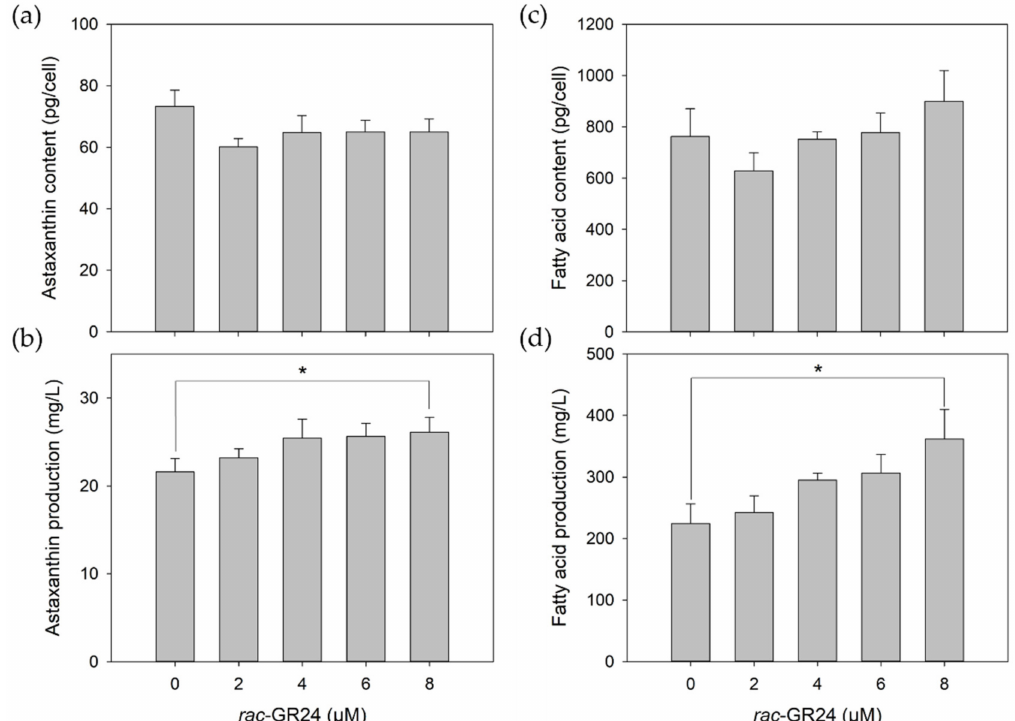
Figure 5. The contents and production of astaxanthin ( a , b ) and total fatty acid ( c , d ) of H. pluvialis after 30 d photosynthetic cultivation under different rac -GR24 concentrations (2.0–8.0 µ M). Asterisk symbol (*) represents the significant differences ( p <